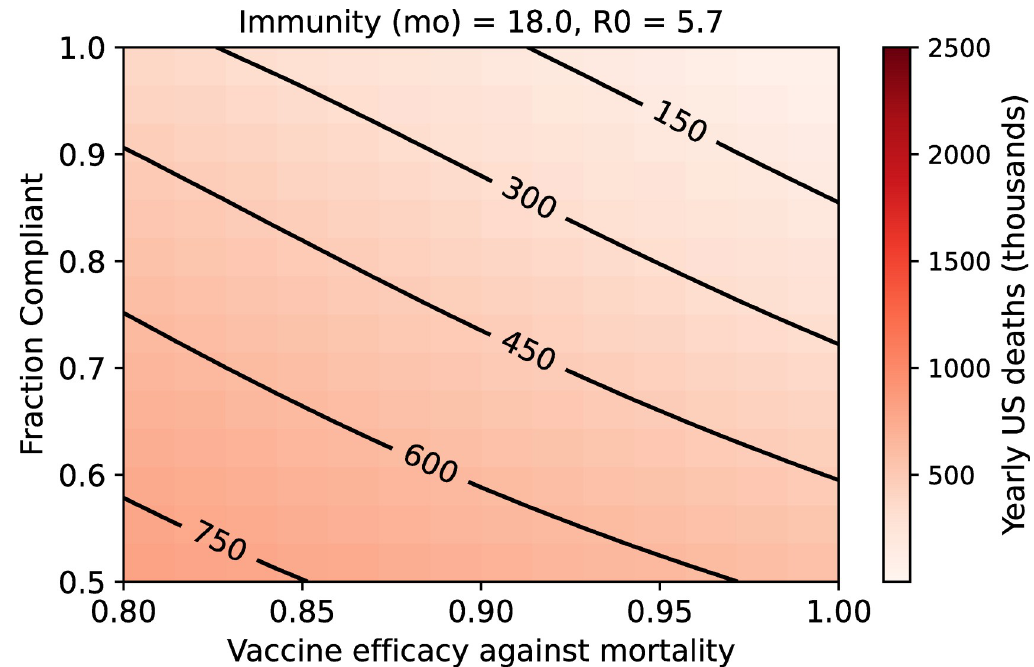
Fig 1. Steady-state yearly US COVID-19 fatalities after rollout of a vaccine that reduces risk of death (R 0 of 5.7 with an 18-month duration of natural immunity).